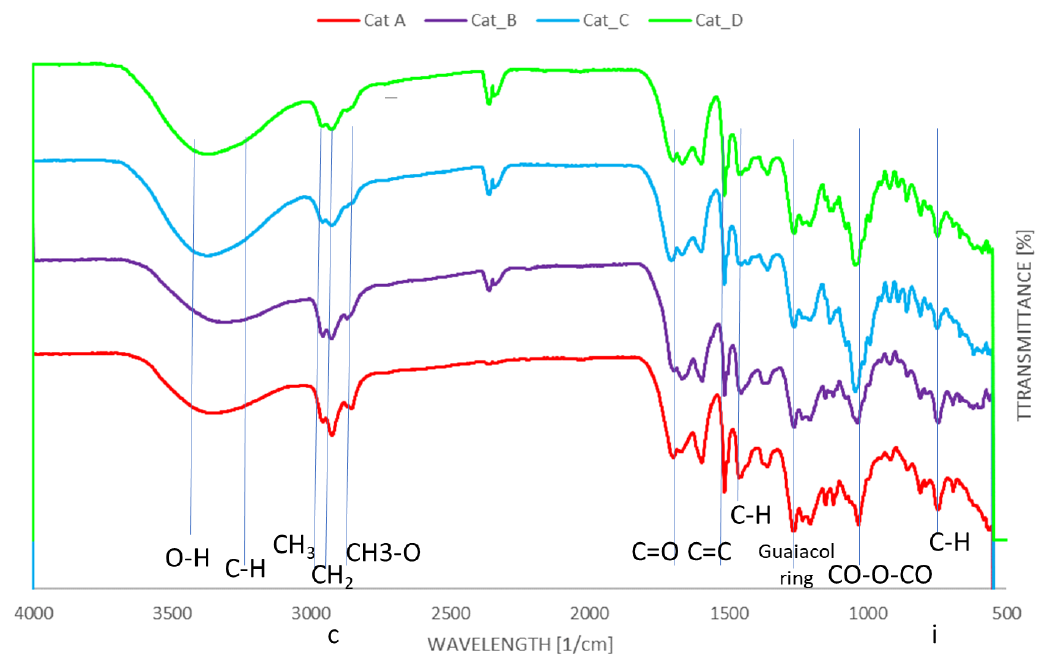
Figure 4. FTIR spectra for the bio-oils produced by using the four catalytic